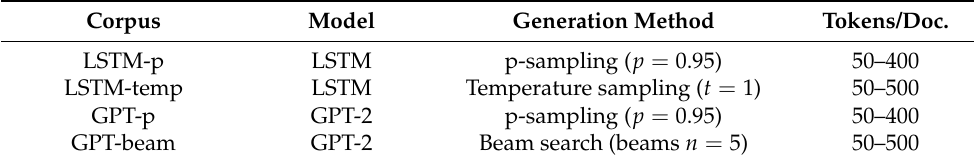
Table 3. Overview of language model decoding parameters to generate four synthetic